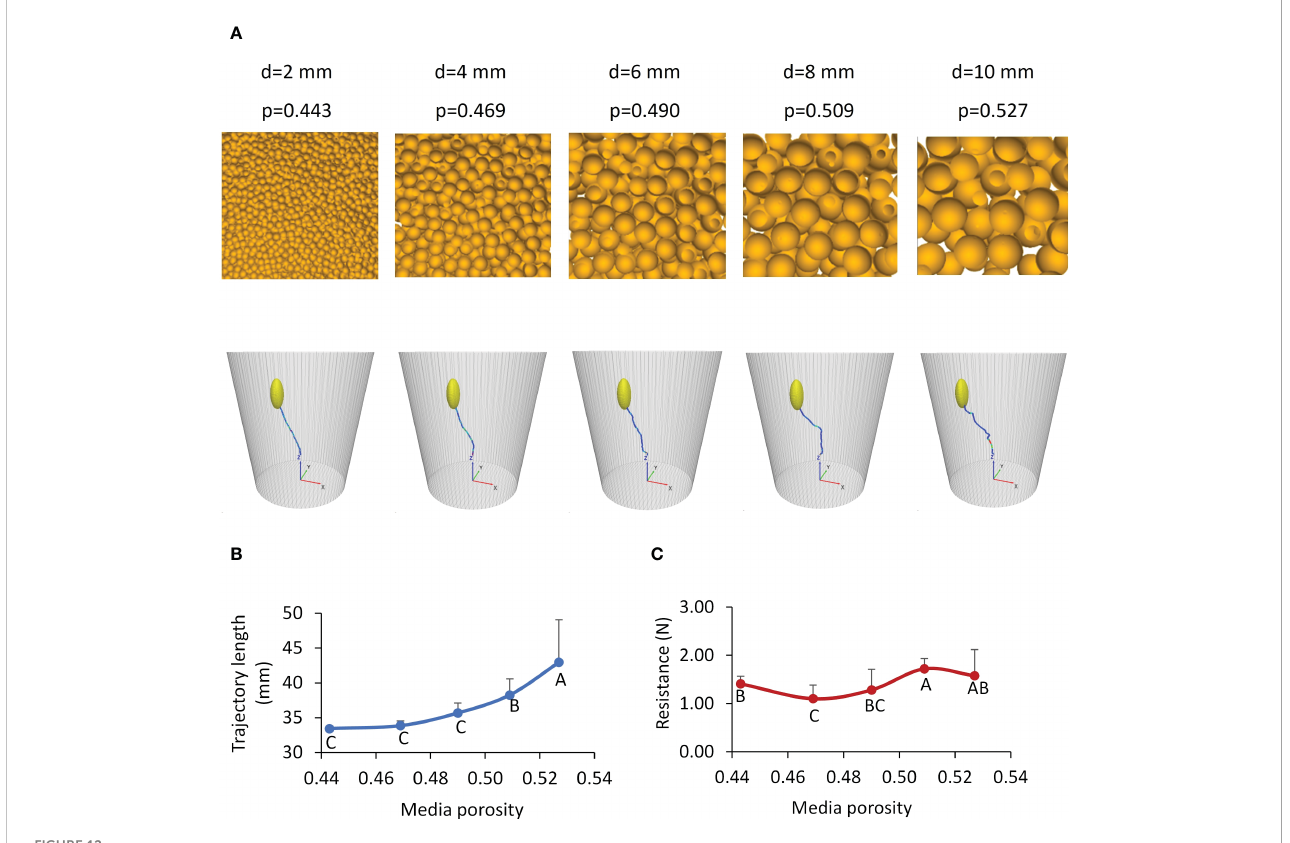
FIGURE 12 Effects of growth medium conditions. (A) Simulated growth media with various porosities (p) created using different particle diameters (d), and the corresponding trajectories of cotyledon. (B, C) Simulated total length of trajectories and average soil resistances to the cotyledon, respectively; values labeled with different letters are statistically different according to Duncan ’ s Multiple Range Test at P<0.05; the error bars stand for standard deviations.